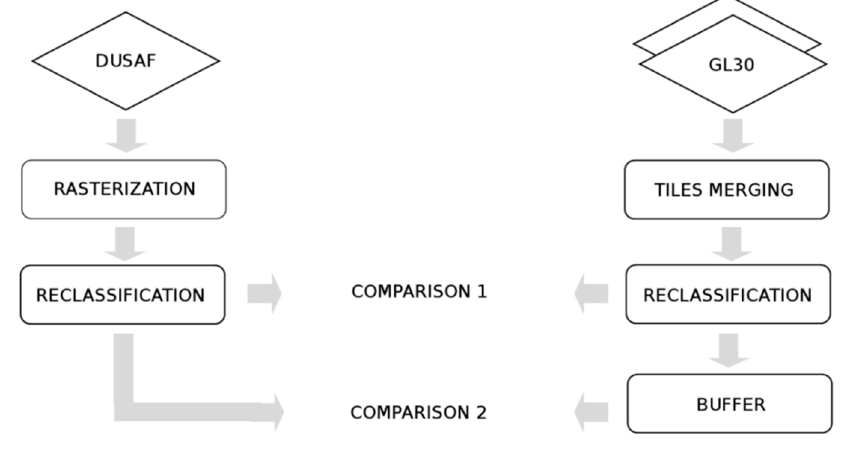
Figure 4. Lombardy Region case study: data processing workflow performed on DUSAF and GlobeLand30 (GL30) datasets. (DUSAF, Italian acronyms for “Use Categories of Agricultural and Forest